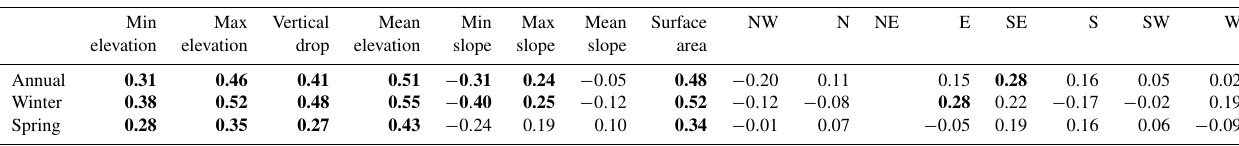
Table 1. Spearman correlation r between morphologic variables and avalanche deposit volumes. Values in bold are significant at the 0.05 level.